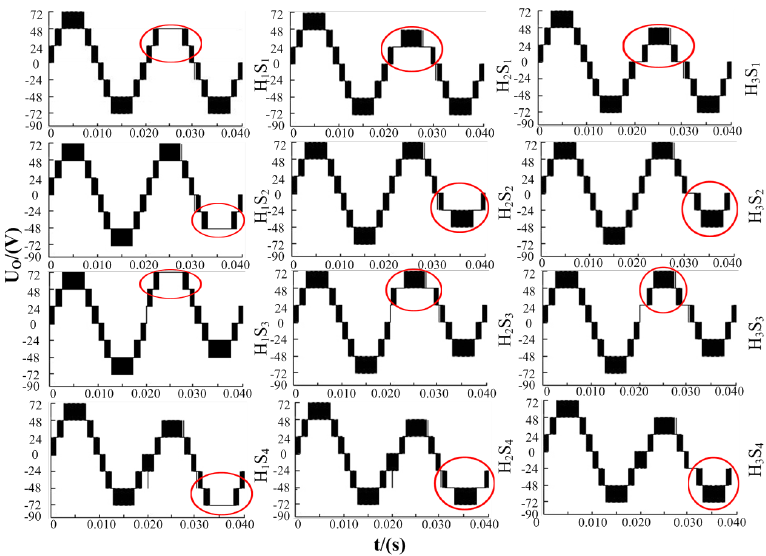
Figure 2. Voltage signals of each switching device in a 7-level CHMI with load of infinite value when an Open Circuit (OC) occurs at 0.02 s.